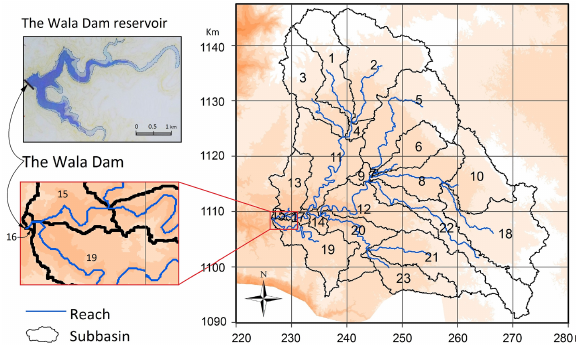
Figure 2. The Wala catchment delineation into subbasins, stream pattern and the catchment